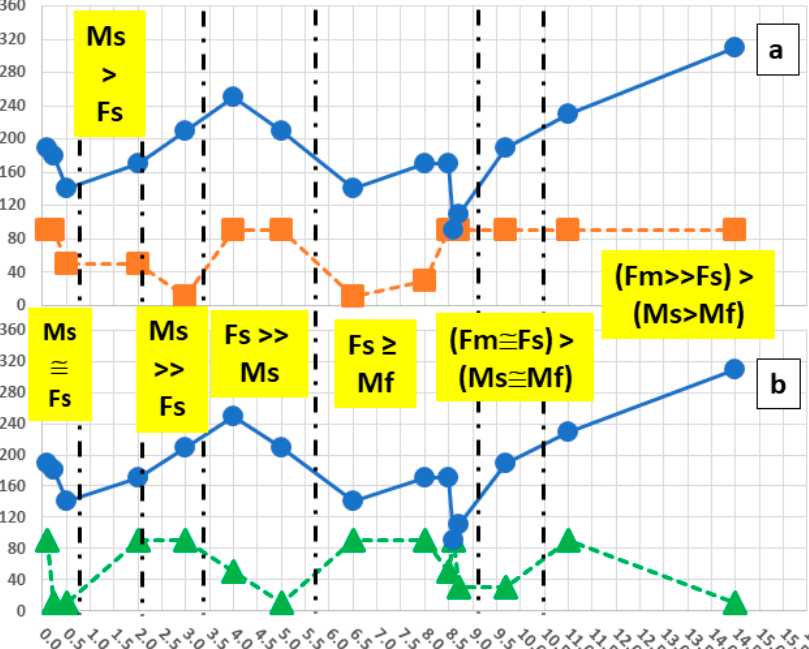
Figure 18. Situmetry (orientation) vs. topography, x-axis denotes in graphs the distance to the source area in km and the sampling sites shown in Figures 3 and 5. The vertical stippled line marks boundaries between the different facies zones of the drainage system. Blue graph: Orientation of the talweg in degree, ( a ) Brown graph: Deviation of the 1st order maximum in the situgram from the talweg given in degree, ( b ) Green graph: Deviation of the 2nd order maximum in the situgram from the